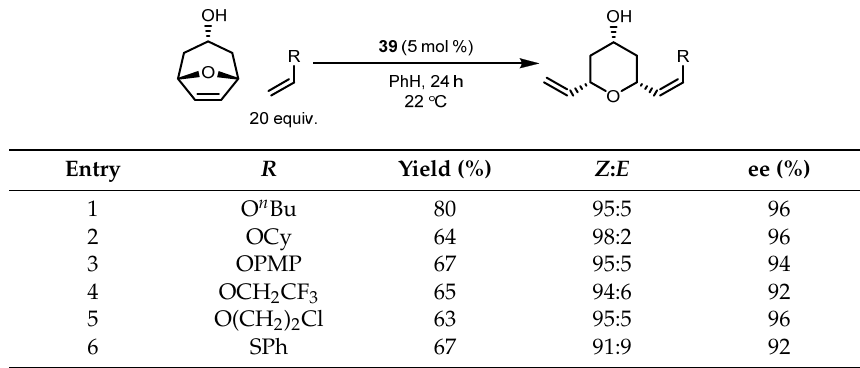
Table 17. AROCM with enol and thiol ethers using a bidentate ruthenium aryloxide.